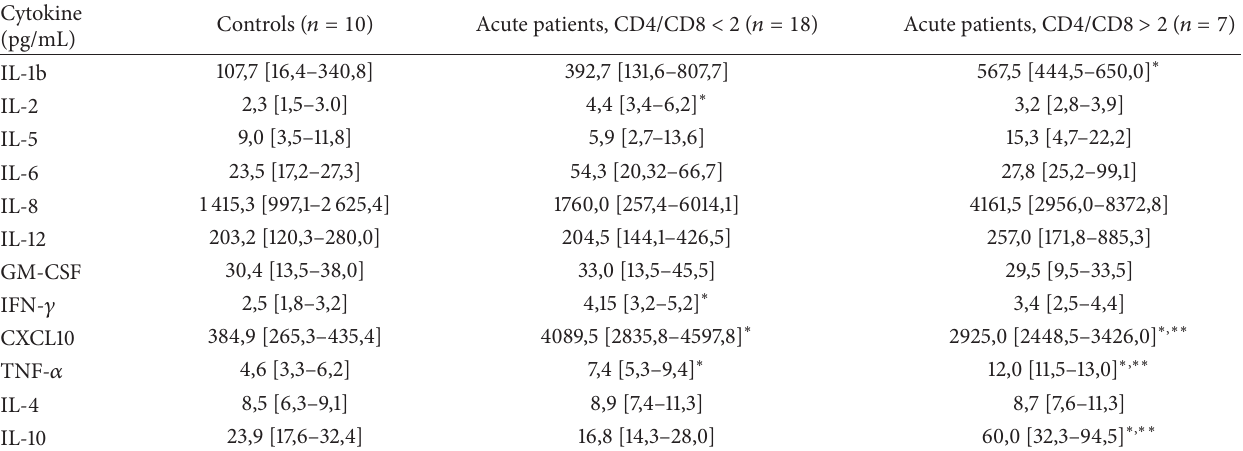
Table 3: Serum cytokine activation in CD4/CD8 ratio subgroups of juvenile CD (median [25th–75th percentile]).